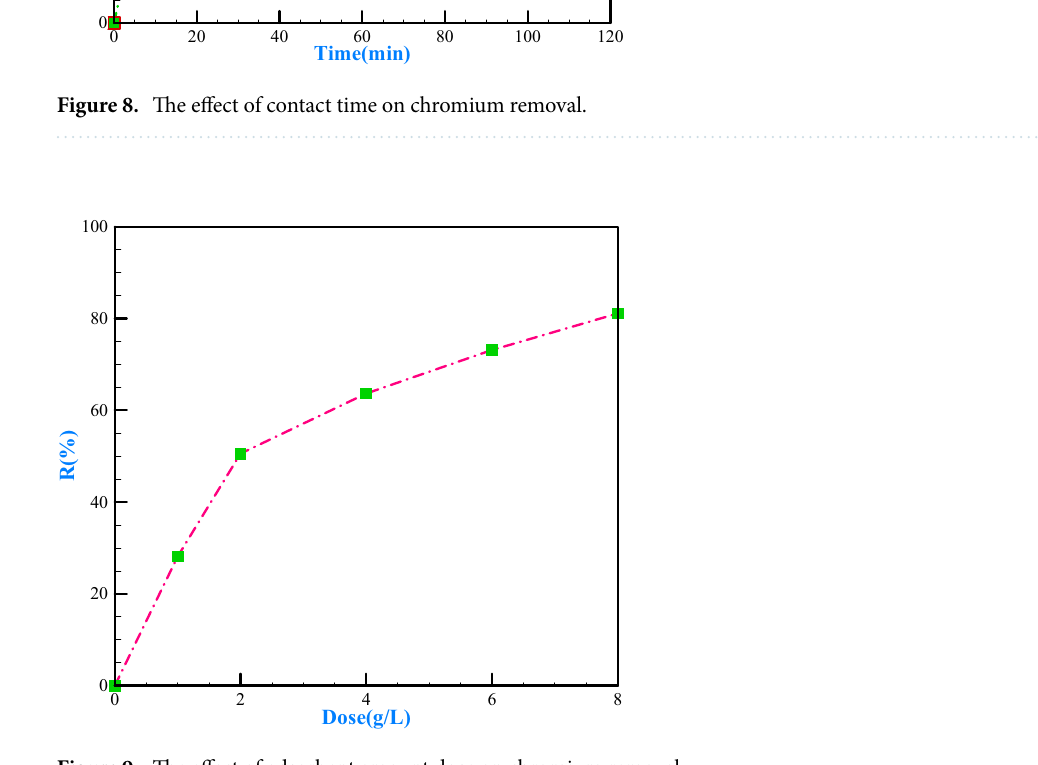
Figure 9. The effect of adsorbent amount dose on chromium